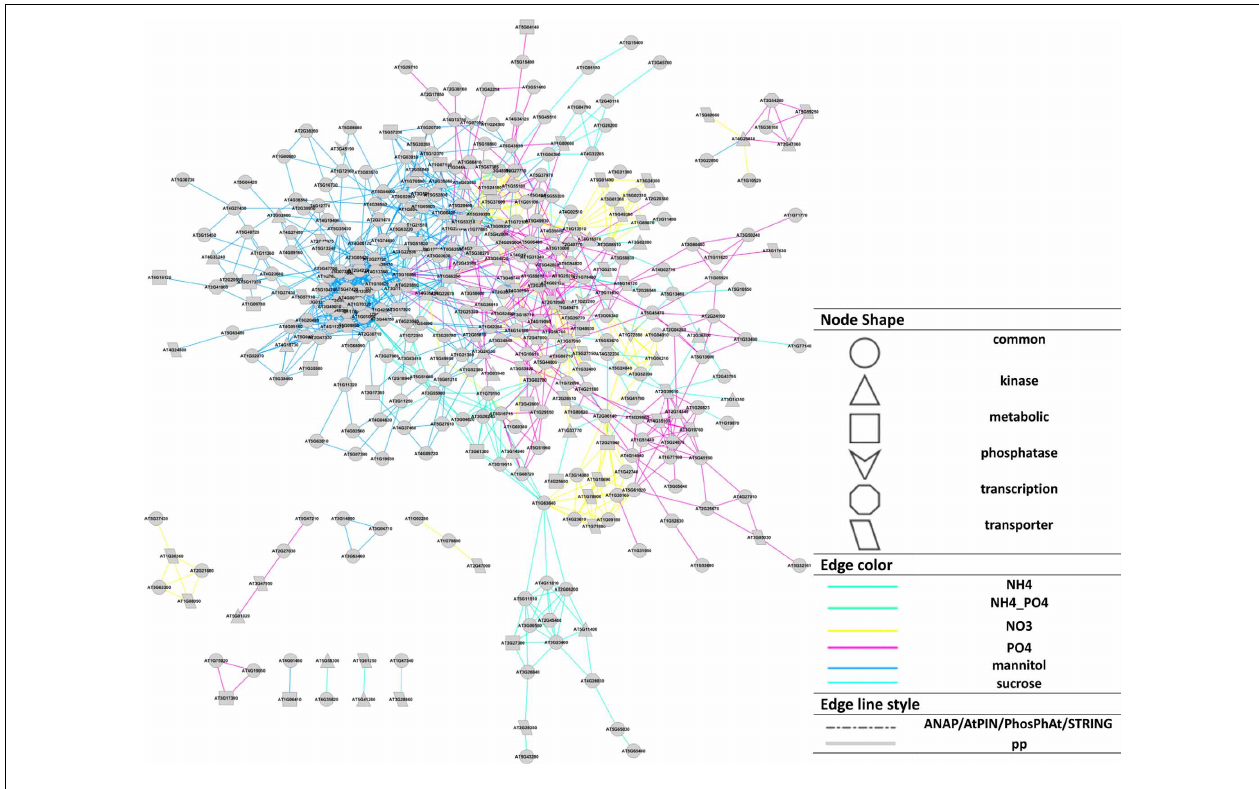
FIGURE 3 | Cytoscape representation (Smoot et al., 2011) of the reconstructed network based on Pearson correlation ( p ≤ 0 . 02 ) . Node shapes represent protein functions, edge colors represent the treatments